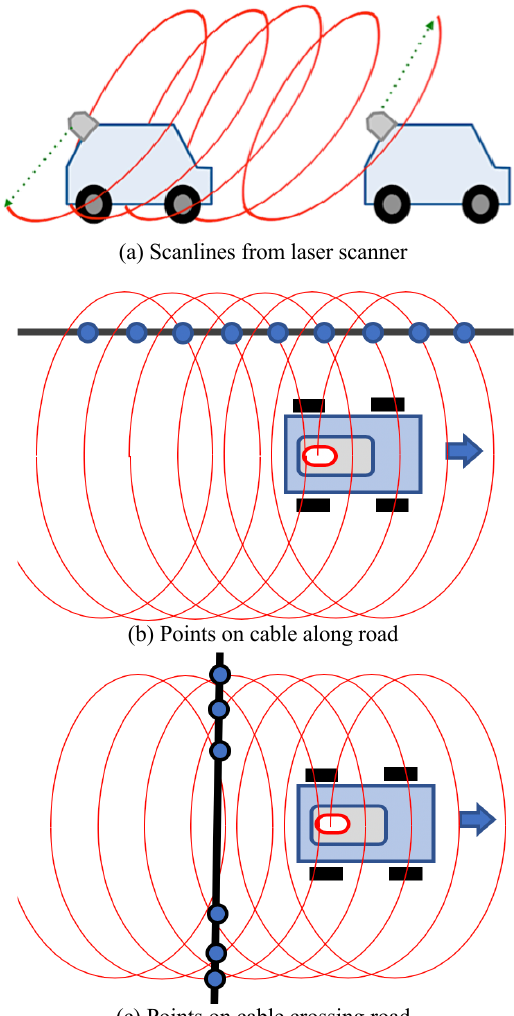
Figure 3. Points scanned from